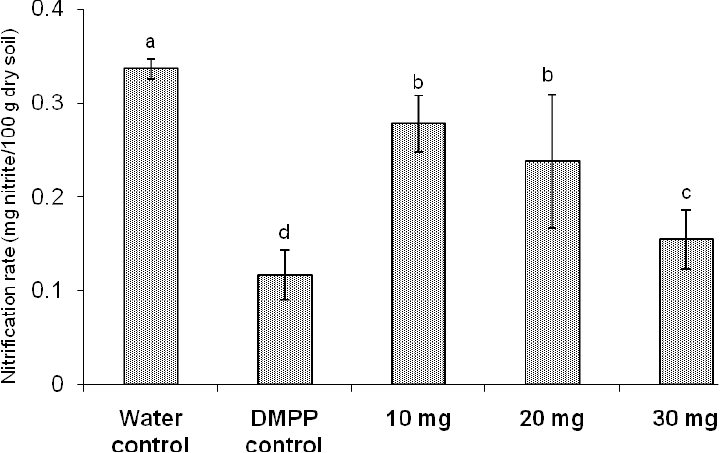
)2SO +50µl NaClO +2.5 ml d-water ± 4 4 3